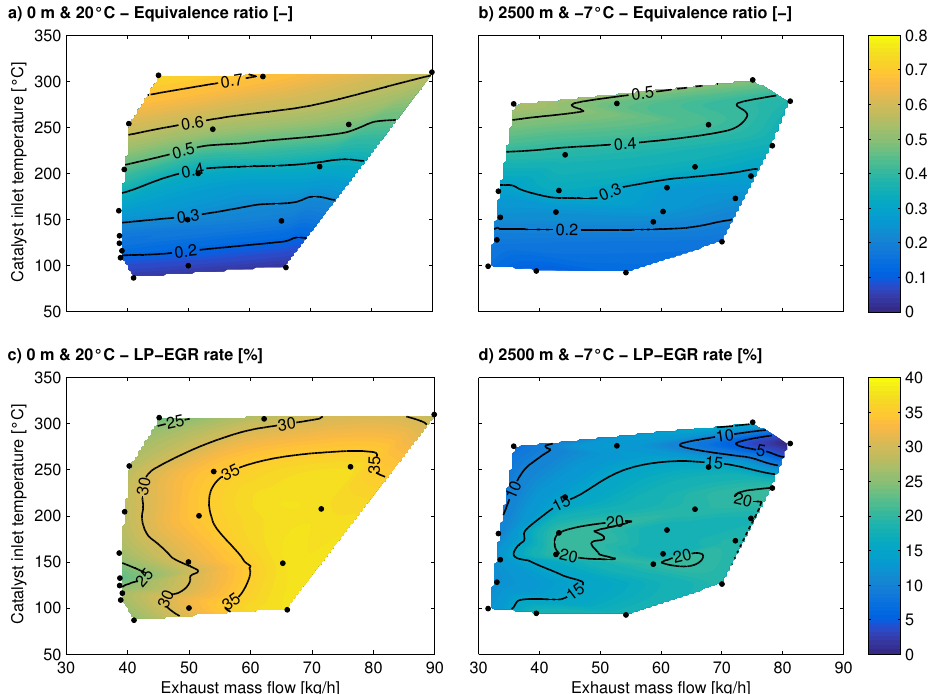
Figure 9. Equivalence ratio and low-pressure-exhaust gas recirculation (LP-EGR) rate as a function of the exhaust mass flow and catalyst inlet temperature: ( a ) equivalence ratio at 0 m and 20 ◦ C; ( b ) equivalence ratio at 2500 m and − 7 ◦ C; ( c ) LP-EGR rate at 0 m and 20 ◦ C; and, ( d ) LP-EGR rate at 2500 m and − 7 ◦